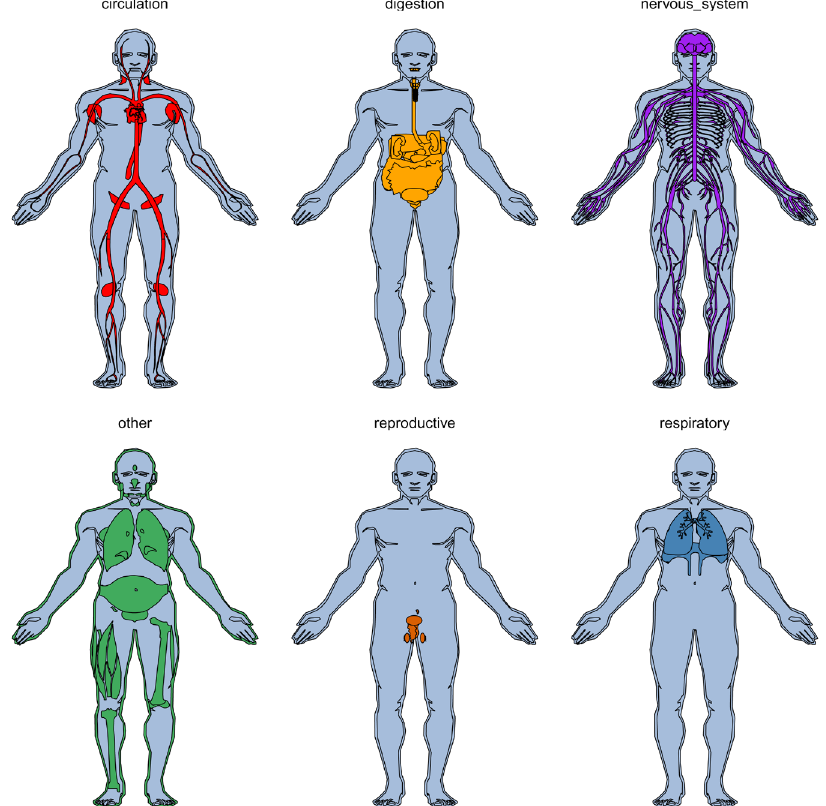
Figure 5. Faceting tissues based on type and displaying the corresponding colour.